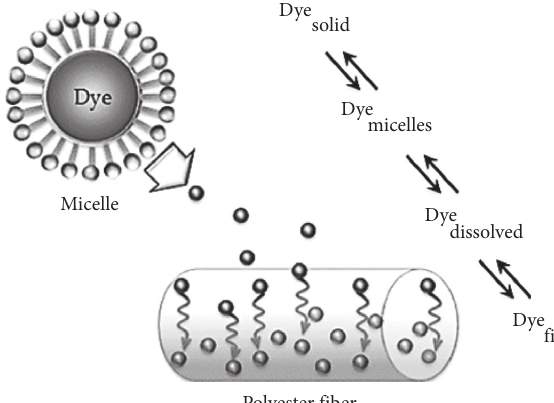
Figure 2: Disperse dyeing mechanism for polyester fibers